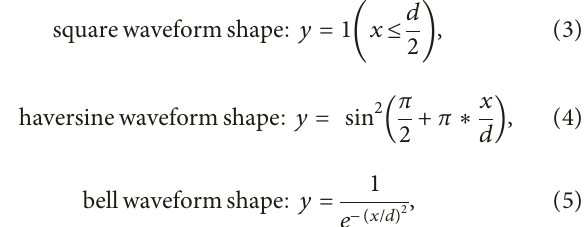
Figure 4(a): the thickness of the AC layer was 15 cm, moduli of the pavement structure were 1,000 MPa, 2,000 MPa, and 40 MPa for the AC layer, base layer, and subgrade, respectively, and the position of interest was at a depth of 10 cm. Figure 4(b): the thickness of the AC layer was 15 cm, moduli of the pavement structure were 10,000 MPa, 20,000 MPa, and 100 MPa for the AC layer, base layer, and subgrade, respectively, and the position of interest was at a depth of 10